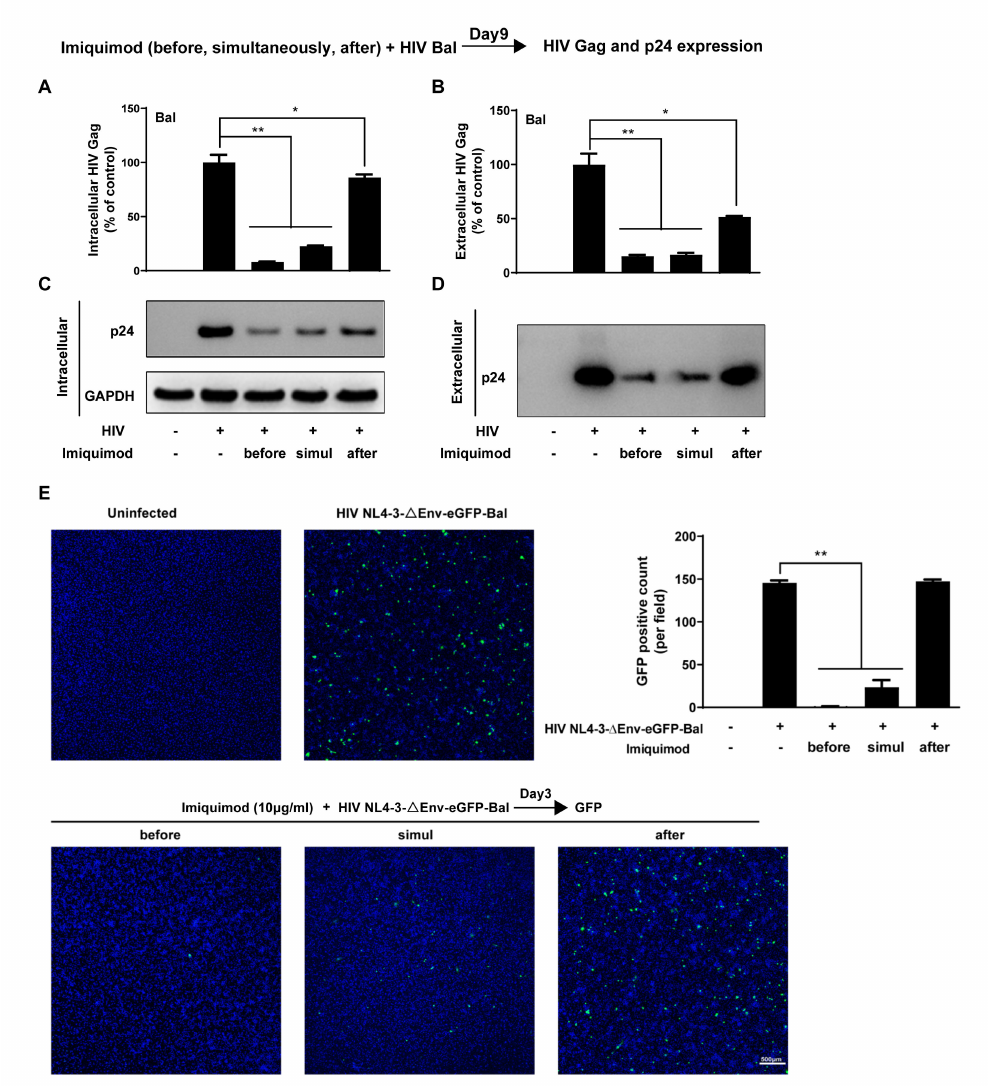
Figure 4. Imiquimod blocks HIV entry into macrophages. ( A – D ) Macrophages were treated with either imiquimod (10 µ g/mL) for 24 h prior to HIV Bal infection (before), or imiquimod and infected with HIV Bal simultaneously (simul), or infected with HIV Bal for 3 h prior to imiquimod treatment (after). Cellular and culture supernatant RNAs were collected on day 9 post-infection and subjected to the real-time PCR for HIV Gag gene expression ( A , B ). Proteins of cells and culture supernatant were collected on day 9 post-infection and subjected to Western blot for HIV p24 expression ( C , D ). ( E ) Macrophages were treated with either imiquimod (10 µ g/mL) for 24 h prior to HIV NL-4-3- ∆ Env-eGFP-Bal infection (before), or imiquimod and infected with HIV NL-4-3- ∆ Env-eGFP-Bal simultaneously (simul), or infected with HIV NL-4-3- ∆ Env-eGFP-Bal for 24 h prior to imiquimod treatment (after). At 72 h post-infection, the green fluorescence was measured by confocal microscope. Data are shown as mean ± SD of 3 independent experiments. Scale bar, 500 µ m (* p < 0.05, ** p <